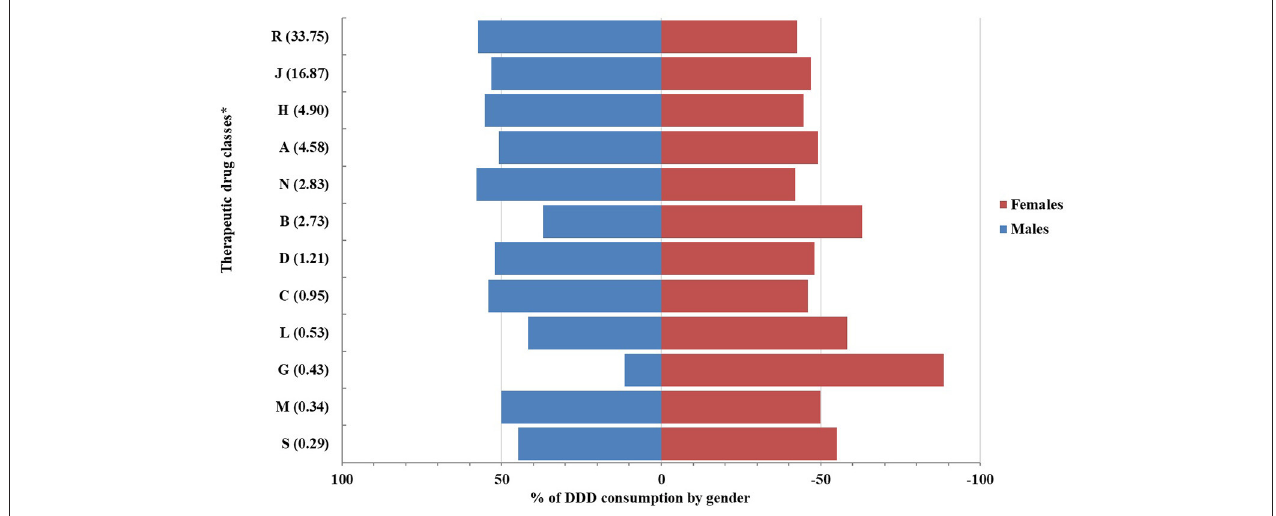
FIGURE 3 | Proportions of drug consumption (by DDD/1,000 persons per day) distributed by gender. *Drug classes by 1st level of ATC (DDD/1,000 persons per day).